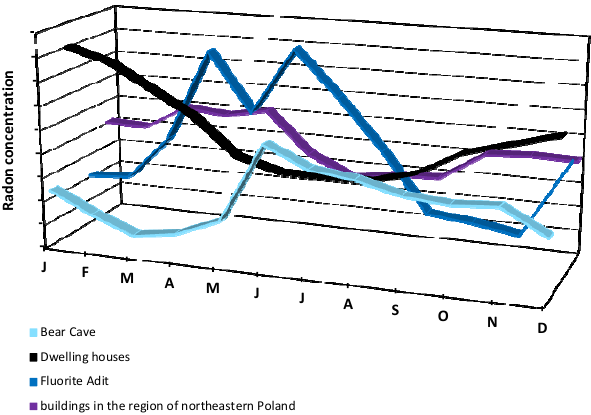
Fig. 8. Fig. 8. Annual pattern of 222 Rn activity concentration changes in two studied underground spaces in Kletno in relation to annual pat- tern of radon concentration changes in residential buildings. The pattern of 222 Rn activity concentration changes in residential build- ings is based on data from the website www.hpa.org.uk, 2010 (res- idential buildings) and data from residential buildings in the North- east of Poland, according to (Karpi ´ nska et al.,